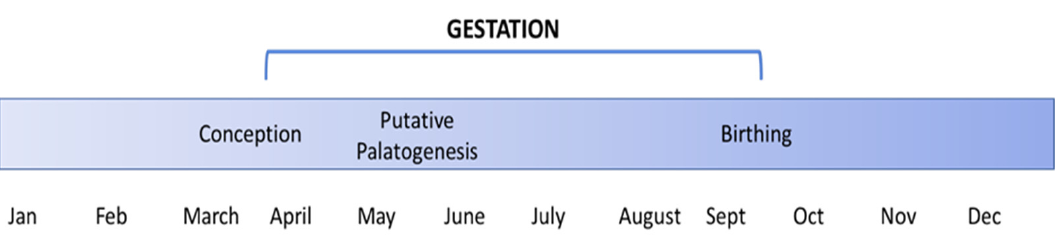
Figure 5. Reproductive timeline of spectacled flying foxes .